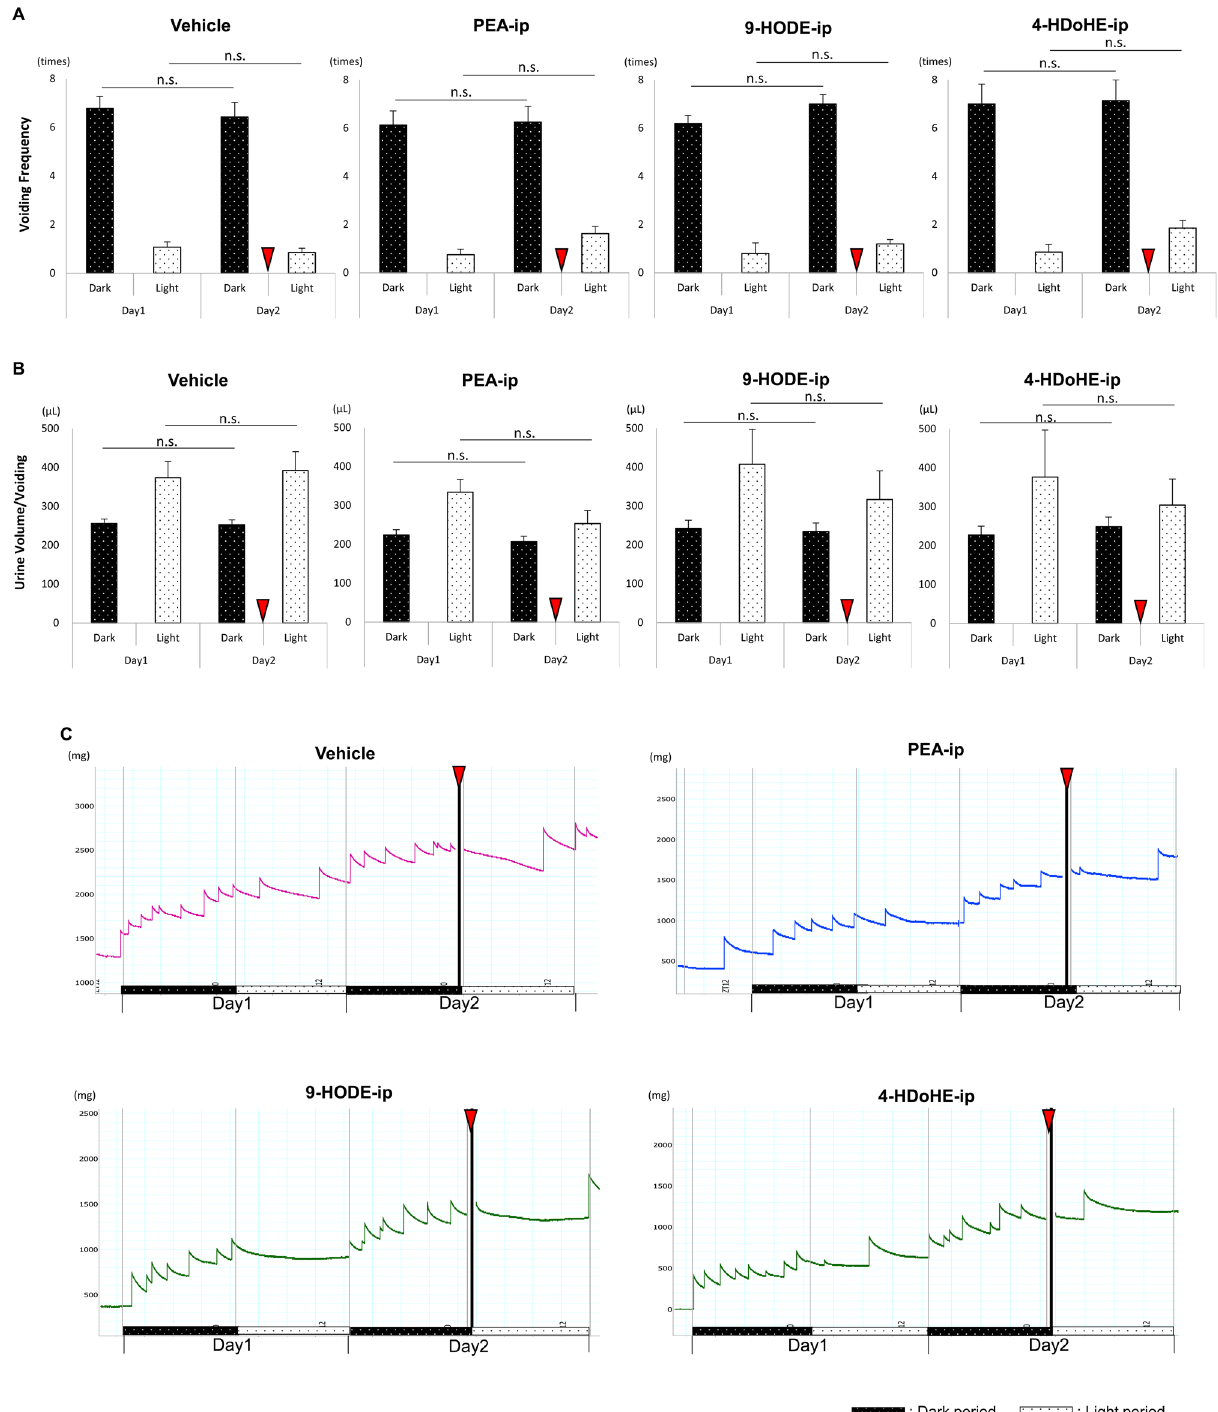
Figure 3. Differences in voiding behavior after intraperitoneal injection of the fatty acid metabolites under the 12 h light/dark cycle (LD) in wild type mice. Voiding frequency (VF) and urine volume per voiding (Uvol/v) were measured for 2 days and the parameters between the same phases (the dark phase on day 1 and day 2, or the light phase on day 1 and day 2) were compared. The intraperitoneal injections of vehicle, 10 mg/kg of PEA (PEA-ip), 10 mg/kg 9-HODE (9-HODE-ip), and 10 mg/kg of 4-HDoHE (4-HDoHE-ip) were performed at the beginning of the light phase on day 2. ( A ) VF between the dark and light phases for 2 days in wild type (WT) mice. ( B ) Uvol/v between the dark and light phases for 2 days in WT mice. ( C ) Representative traces of voiding of WT mice after injecting the vehicle, PEA, 9-HODE, and 4-HDoHE. Differences in VF were analyzed using paired t test. Differences in Uvol/v were analyzed using Mann–Whitney’s U -test. Data are presented as mean ± standard error (SE). p < 0.05 was considered significant. n.s., not significant. Red arrow heads indicate the time point of